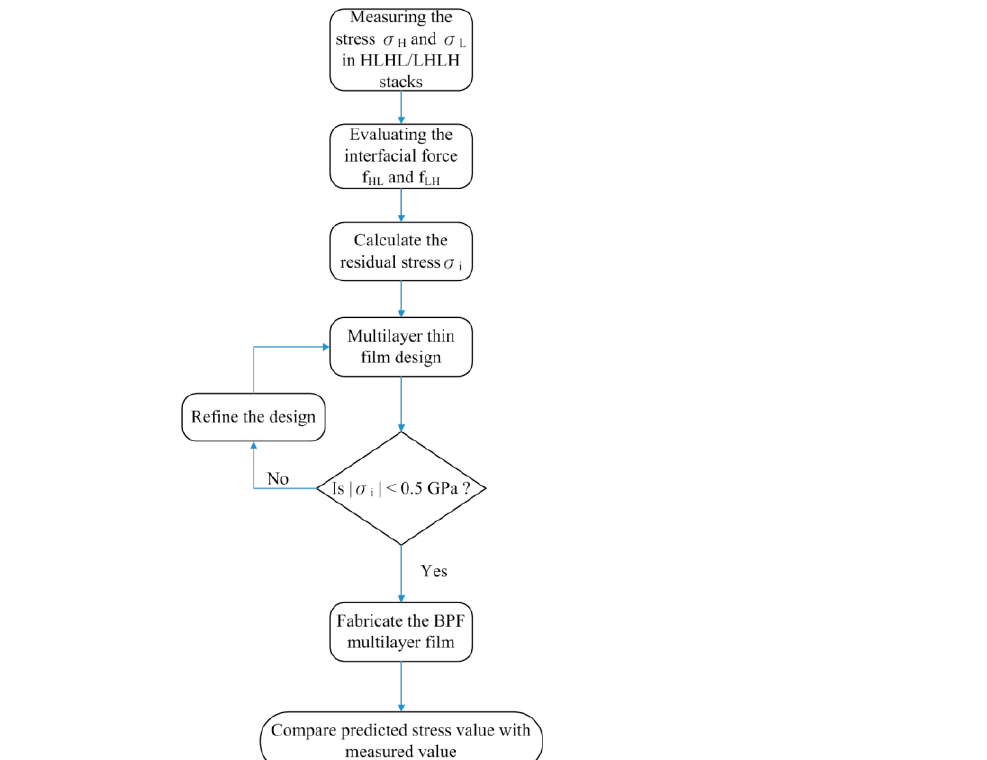
Figure 2. The flow chart of mid-infrared band-pass filters (MIR-BPFs) design.